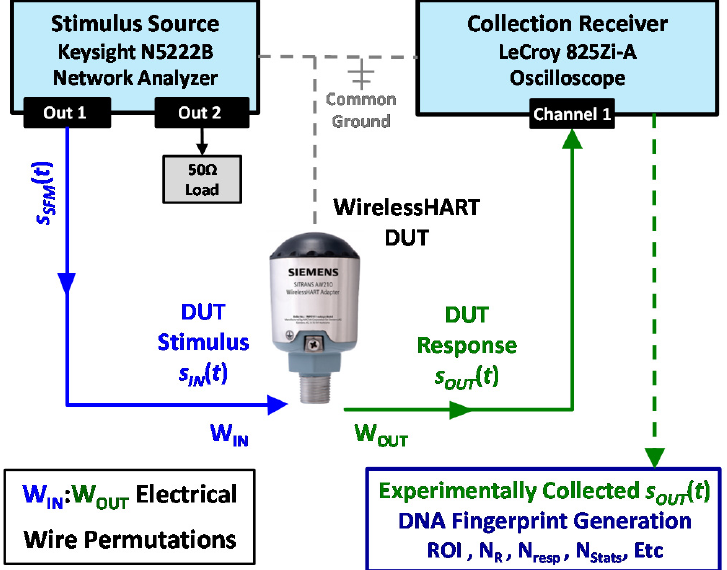
Figure 1. Experimental setup similar to that used in [19] for collecting WirelessHART DUT responses used for active DNA fingerprint generation.